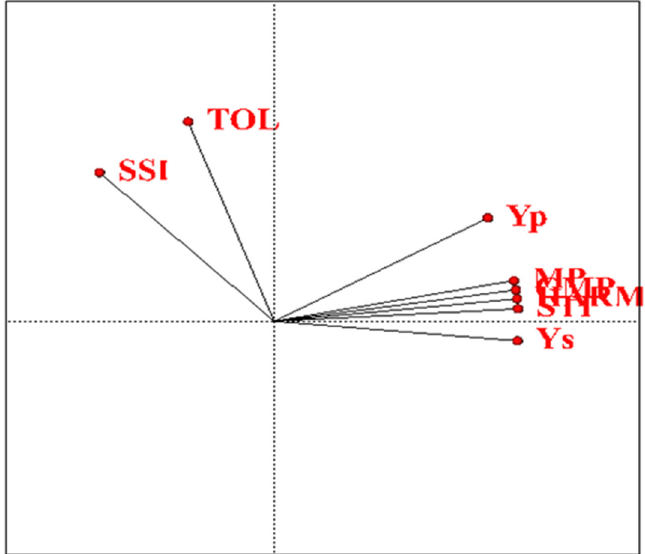
Figure 6. Correlation diagram between drought-tolerance indices studied under water stress condi- tions. Yp: Yield under normal condition, Ys: yield under drought condition, TOL: Tolerance, MP: Mean Productivity, GMP: Geometric Mean Productivity, HARM: Harmonic Mean Productivity, SSI: Stress Susceptibility Index, STI: Stress Tolerance Index.